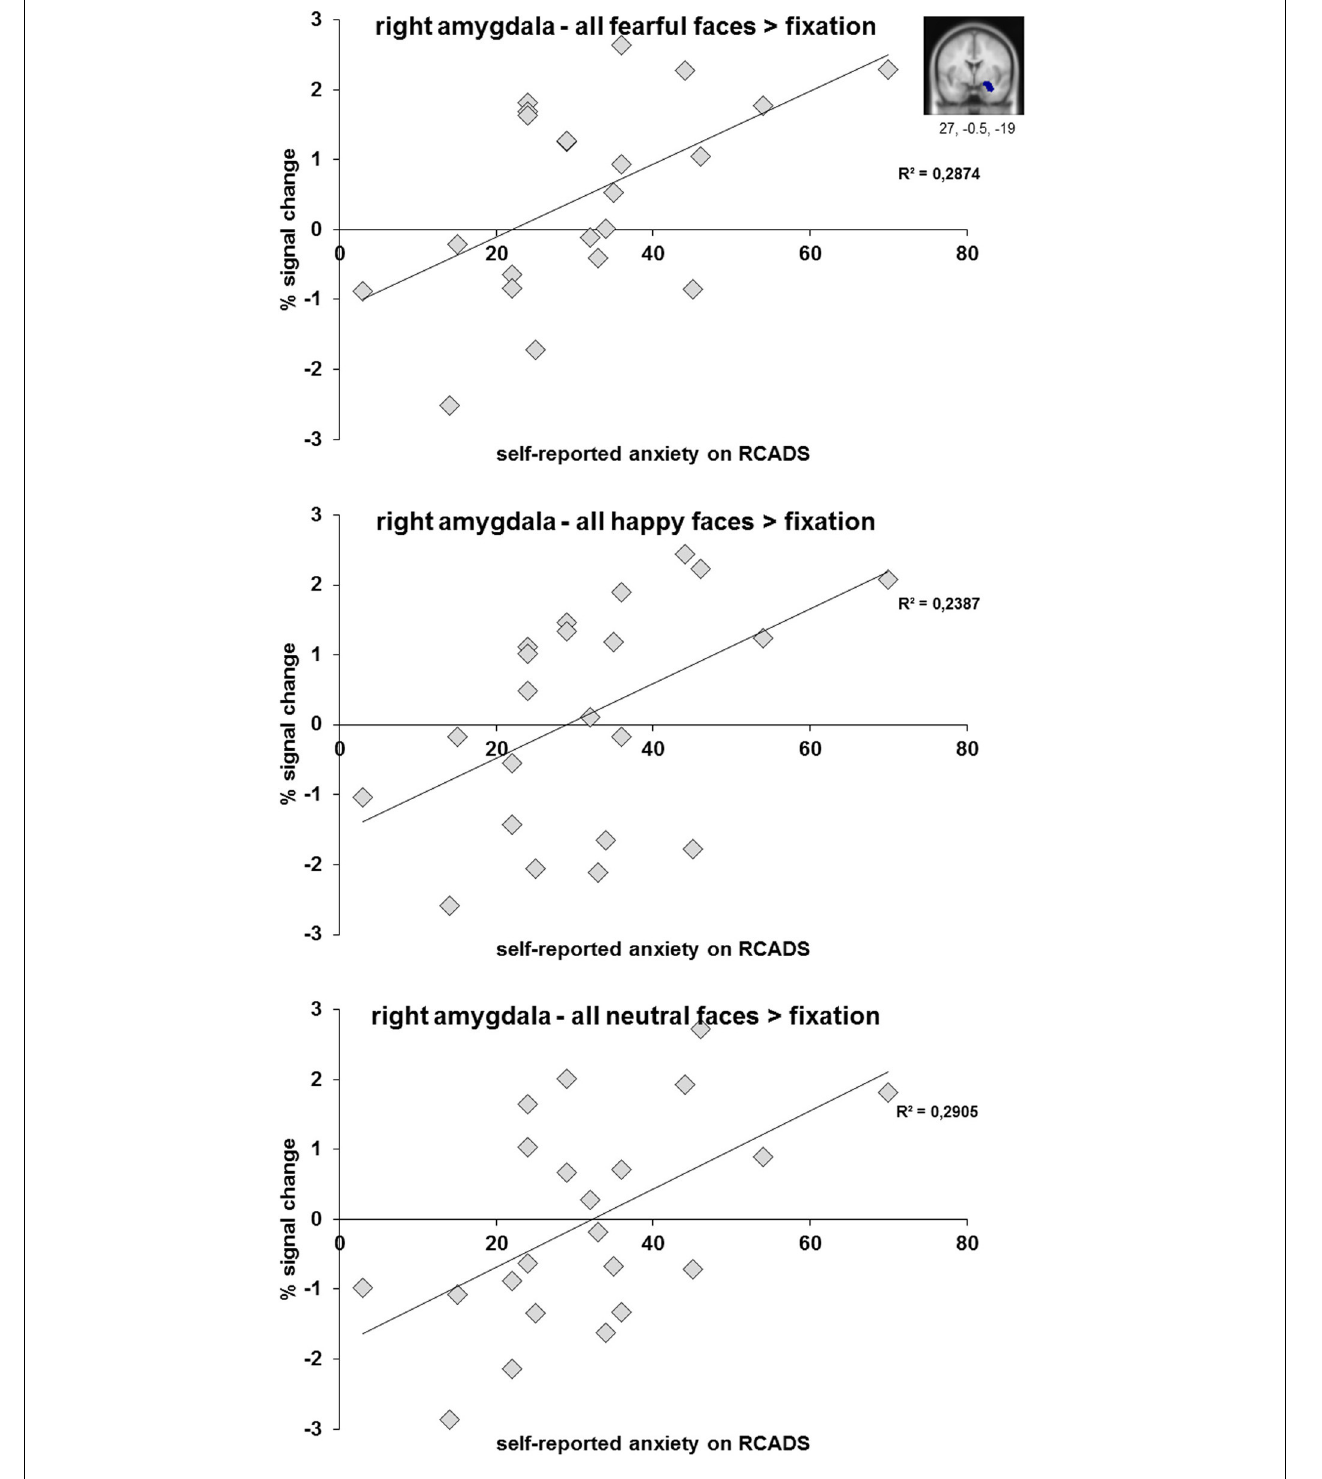
FIGURE 5 | Scatter plots of the correlation analyses between right amygdala activation (anatomical ROI) during the processing of fearful, happy, and neutral faces and subjective